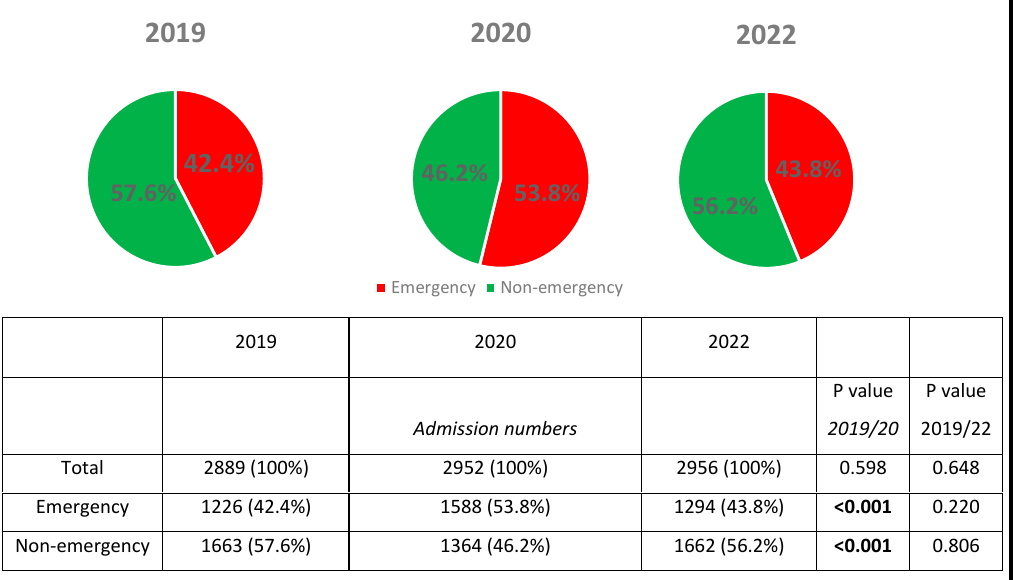
Figure 1. Comparison of the number of cardiac emergency and non-emergency admissions in 2019,